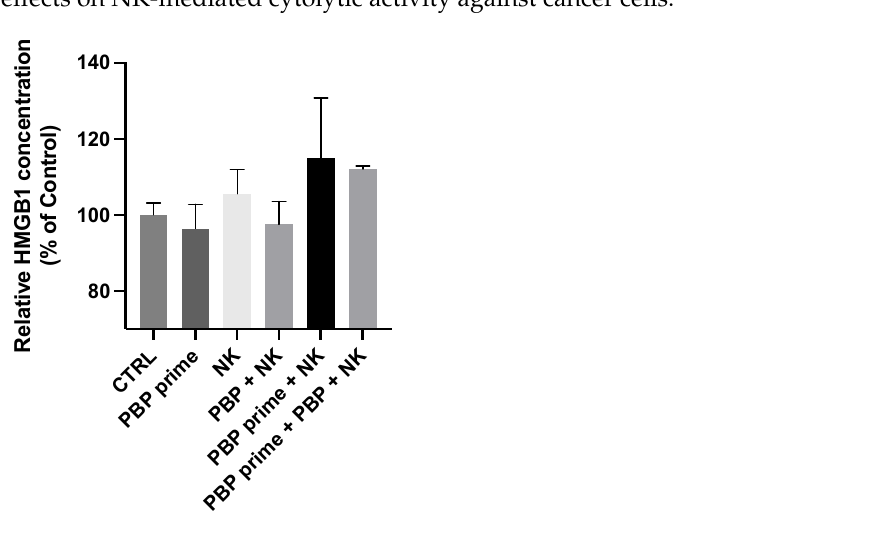
Figure 3. Relative HMGB1 concentration in culture supernatants. HMGB1 secretion by PBP-primed B16F10 cells did not vary significantly from control cultures. However, PBP primed B16F10 cells cultured with NK cells exhibited greater HMGB1 secretion into the culture supernatants.